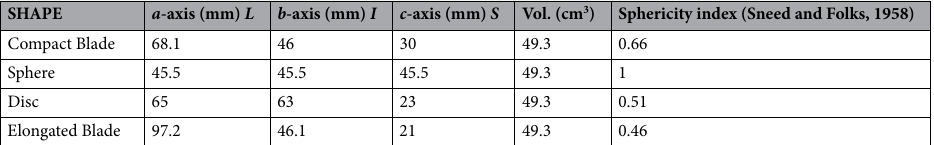
Table 1. Shape characteristics of the artificial particles tracked in the